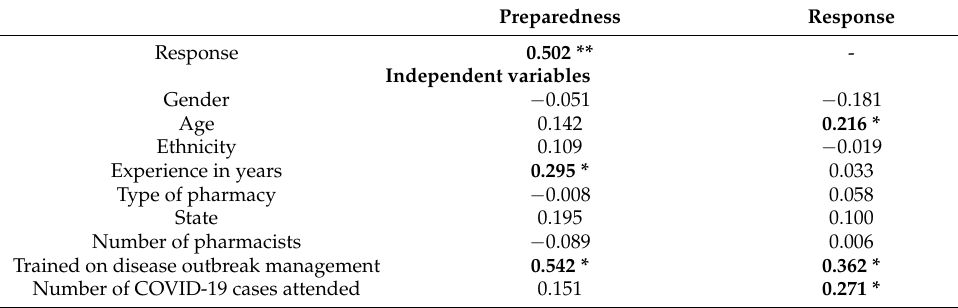
Table 4. Correlation among PR and between PR and independent